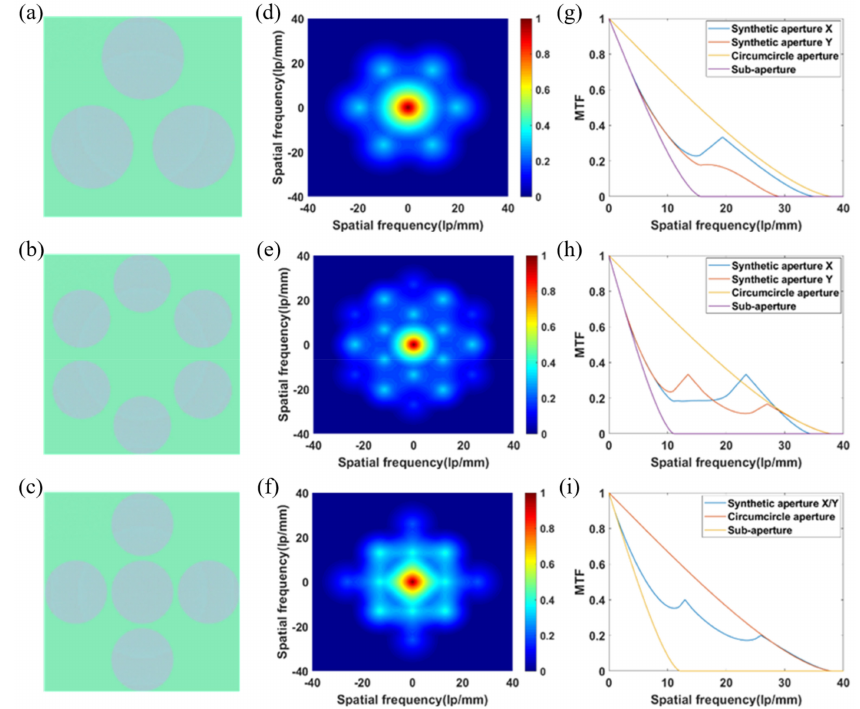
Figure 7. ( a – c ) Schematic of the SAMs with structures of Golay3, Annulus and Cross, respectively. ( d – f ) Calculated MTFs of the SAMs. ( g – i ) MTFs of the SAMs in the X − and Y − axis directions.